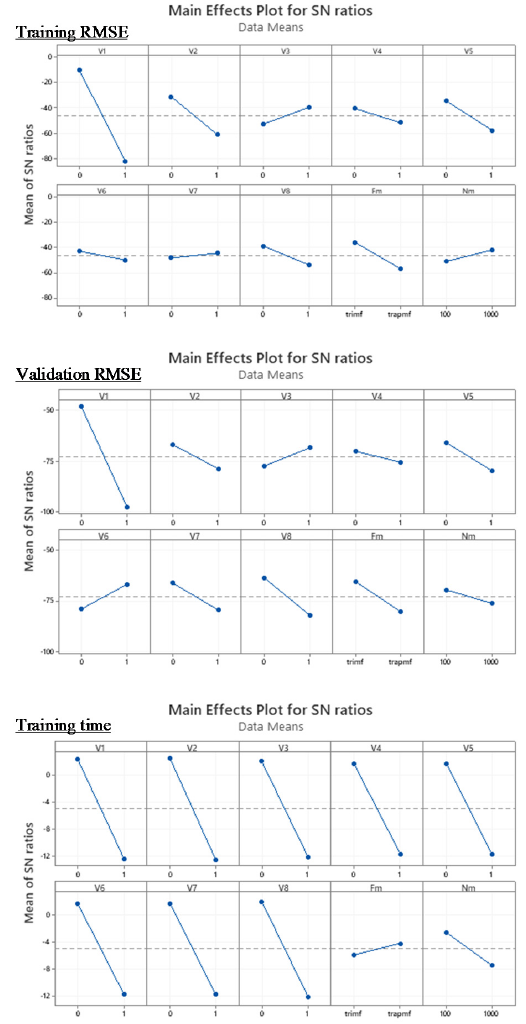
Figure 6. Main effect plots for signal-to-noise ratios in electricity consumption forecasting. Figure 6. Main e ff ect plots for signal-to-noise ratios in electricity consumption